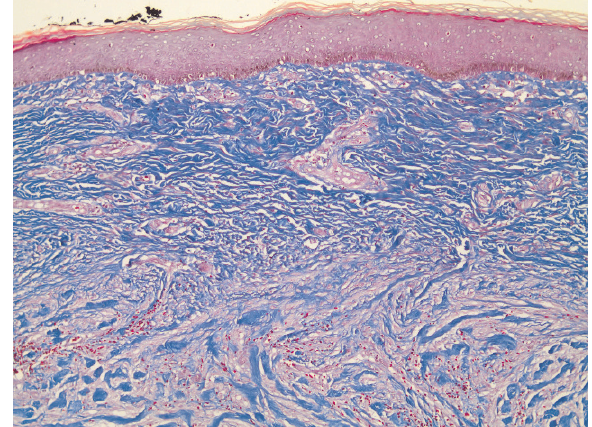
Figure 4 - The histology of keloids is characterized by well- demarcated and disorganized fibrous tissue usually involving the upper half or two-thirds of the dermis. The collagen fibers are noticeably thicker (Masson’s trichrome,